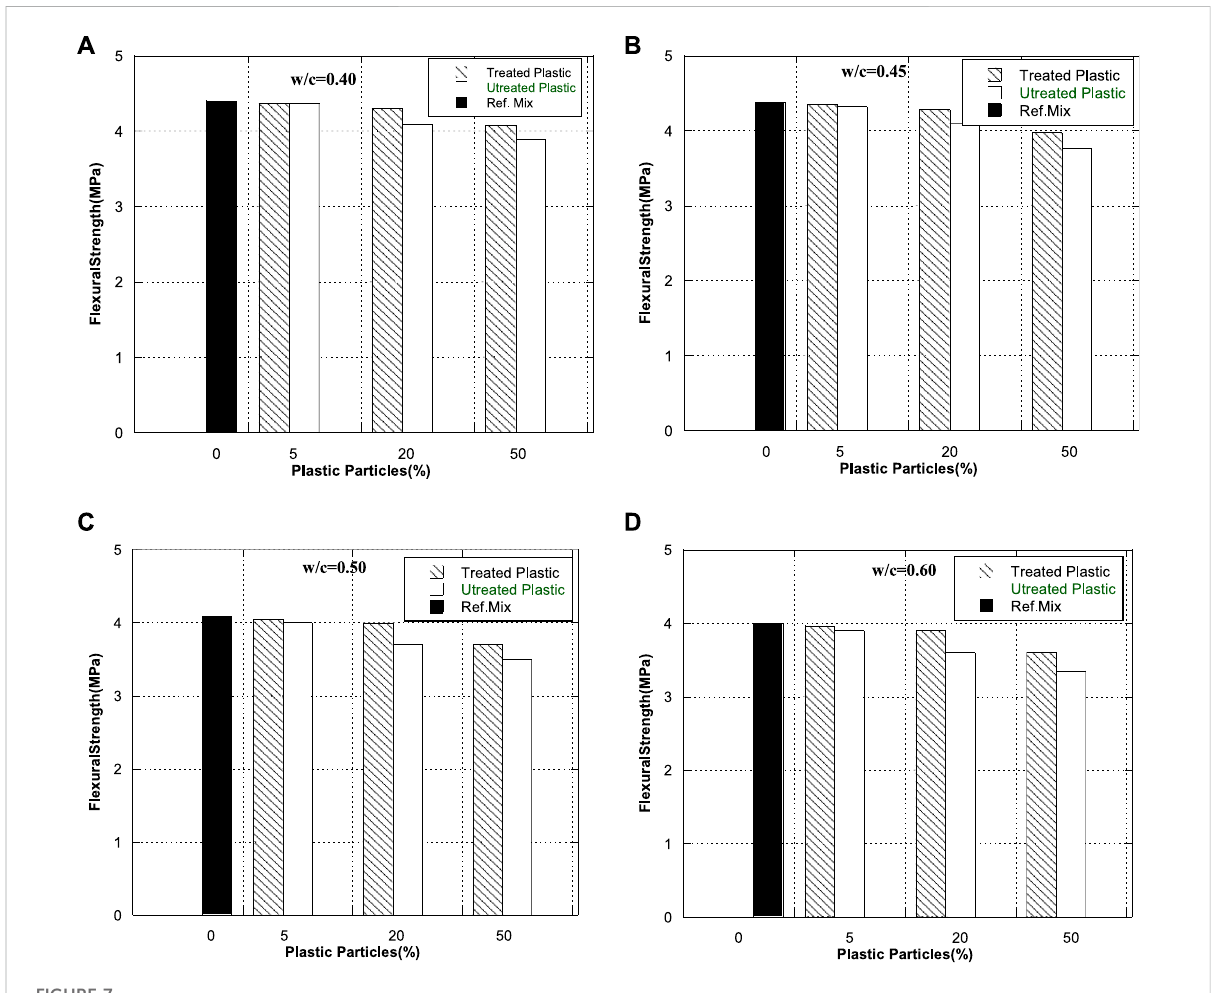
FIGURE 7 Flexural Strength for different mixes (A) w/c = 0.40, (B) w/c = 0.45, (C) w/c = 0.50, and (D) w/c =